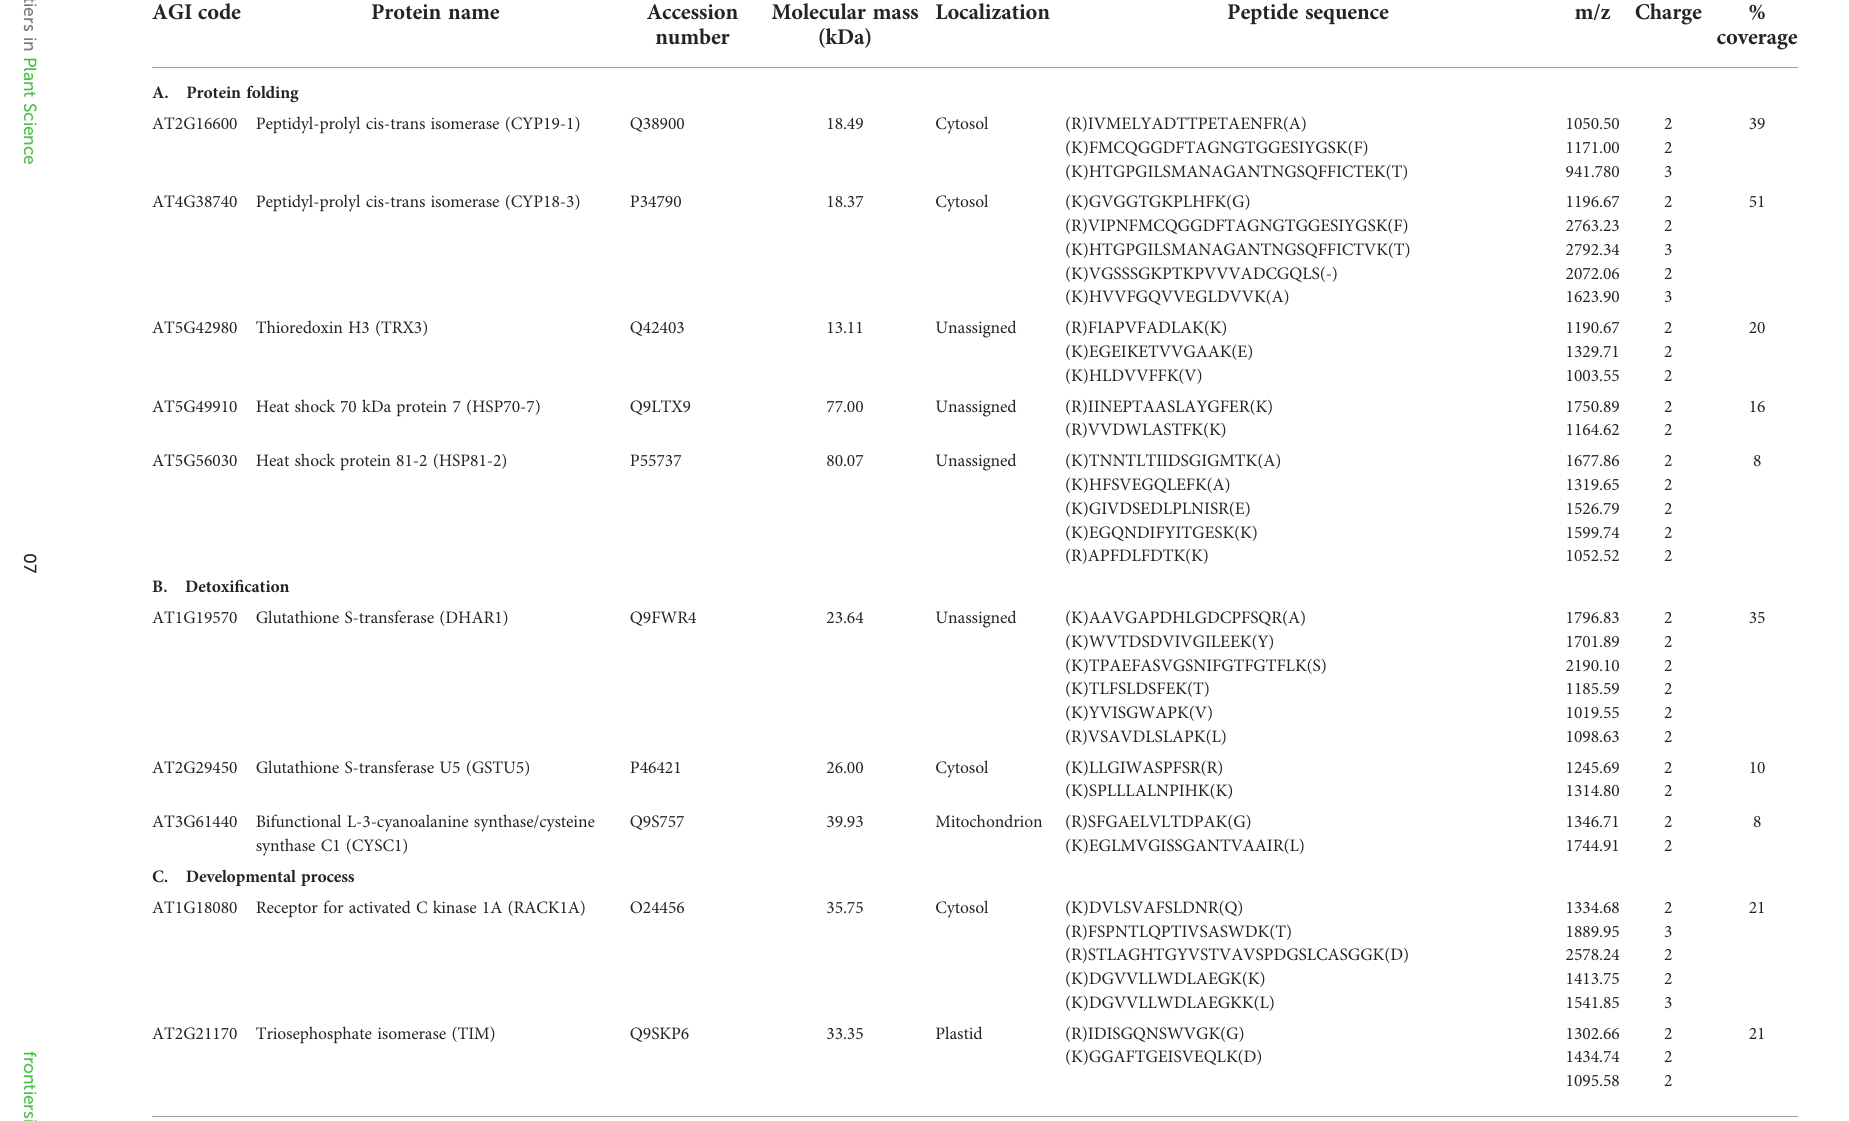
TABLE 1 Examples of carbonylated proteins identi fi ed only in the control plant samples a